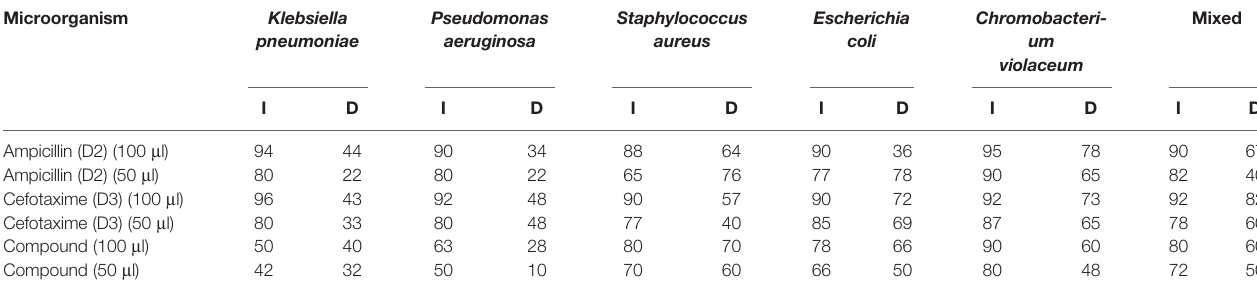
TABLE 3 | Percentage inhibition (I) and degradation (D) observed by the plant extract of Carissa carandas . Microorganism